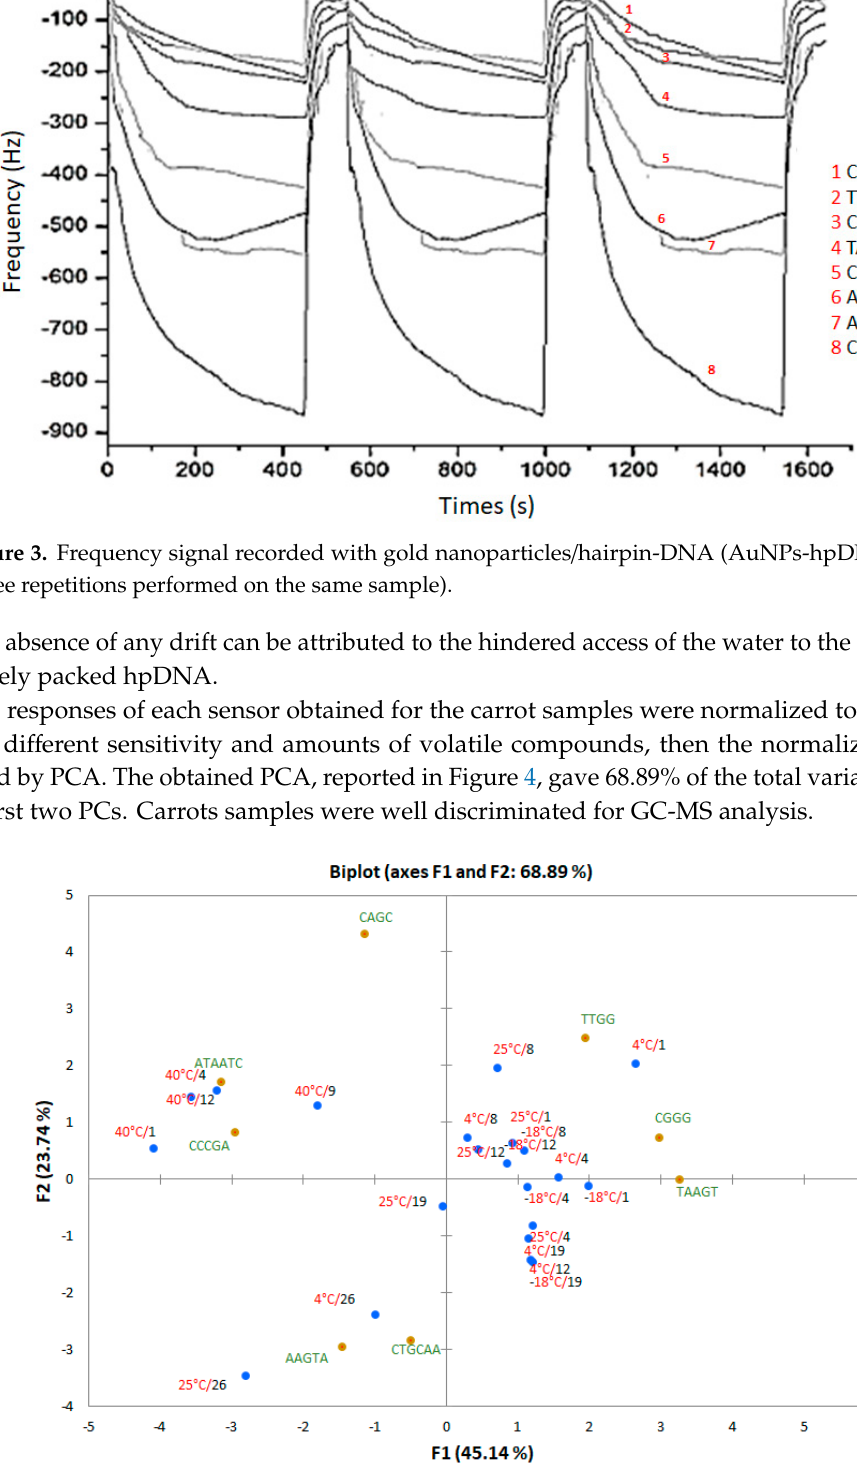
Figure 4. PCA biplot (scores and loadings) obtained with the electronic nose (E-nose) responses of the whole set of carrot samples. Data were normalized before PCA.